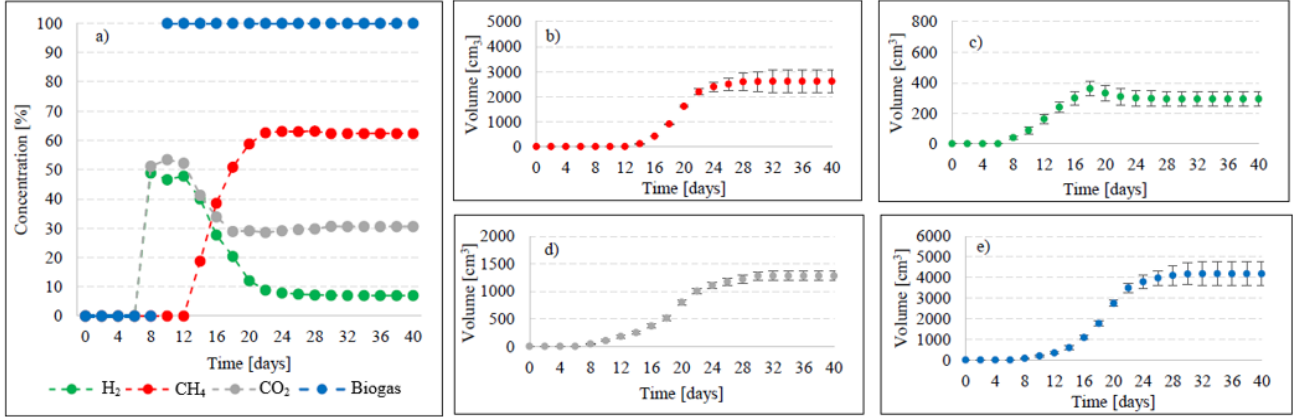
Figure 7. Changes in concentrations of biogas fractions in V5 ( a ); total volumes of CH 4 ( b ), H 2 ( c ), CO 2 ( d ) and biogas ( e ).